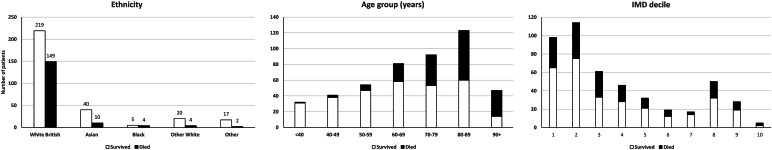
Sociodemographic characteristics of patients admitted with Covid-19 to Royal Oldham Hospital, UK stratified by survival to 30 days post-discharge. IMD, index of multiple deprivation, where the first decile represents highest level of deprivation.